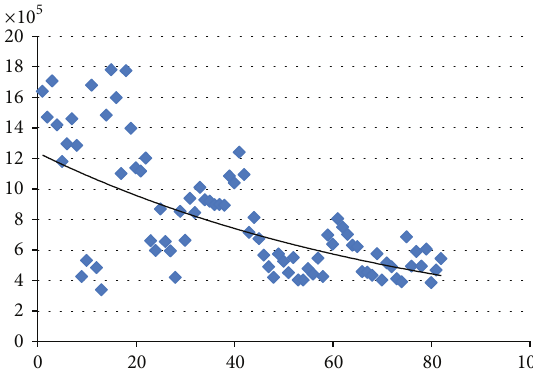
Figure 2: Popularity of Supernatural fades